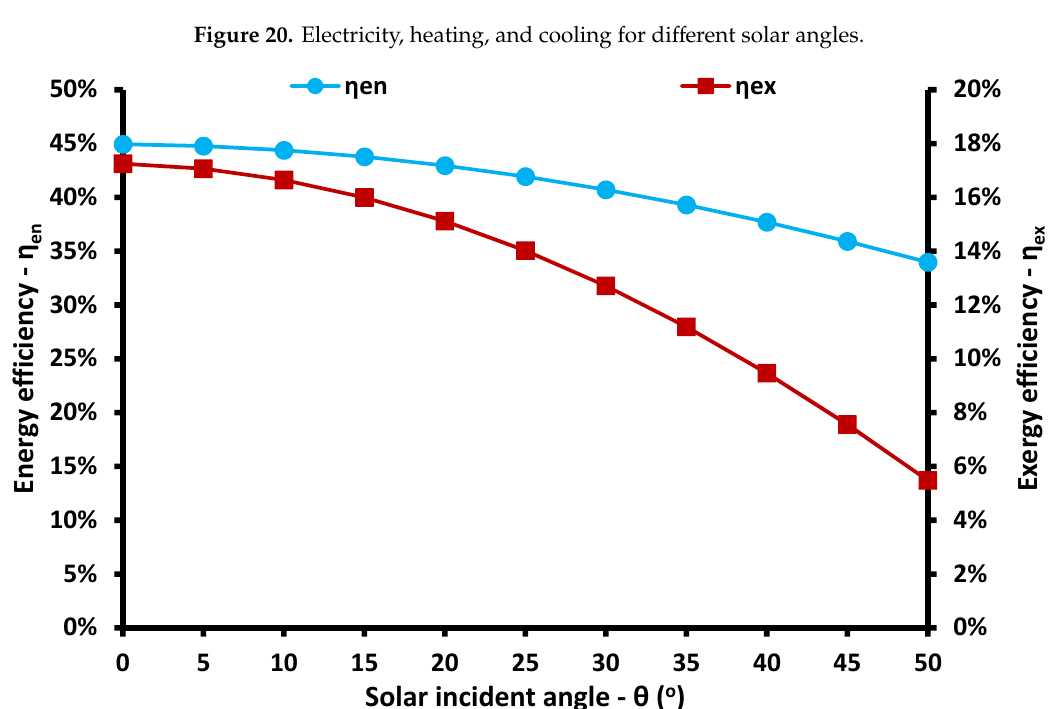
Figure 21. Energy and exergy efficiency for different solar angles.